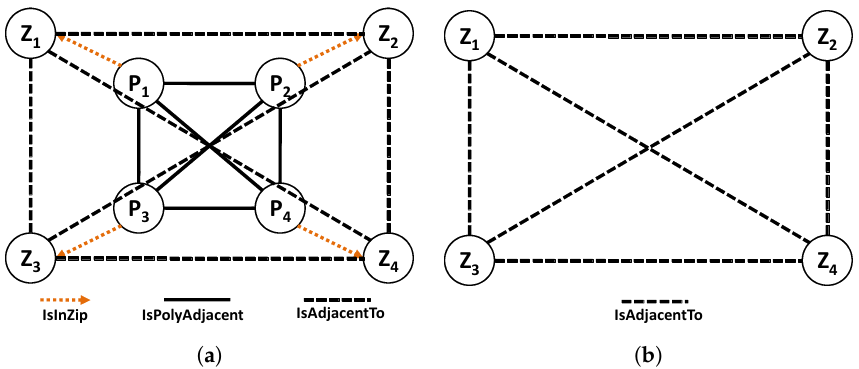
Figure 9. Building ZIP codes—Steps 4 and 5. ( a ) Step 4; ( b ) Step